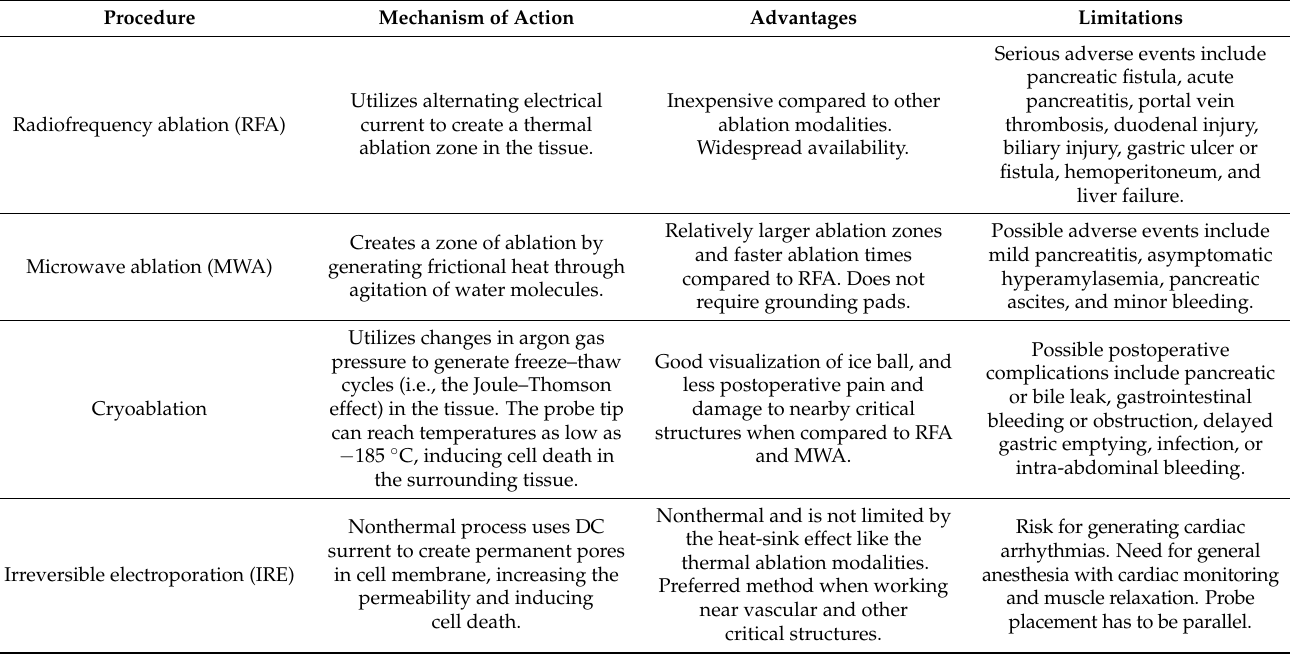
Table 1. Comparison of ablative modalities in pancreatic